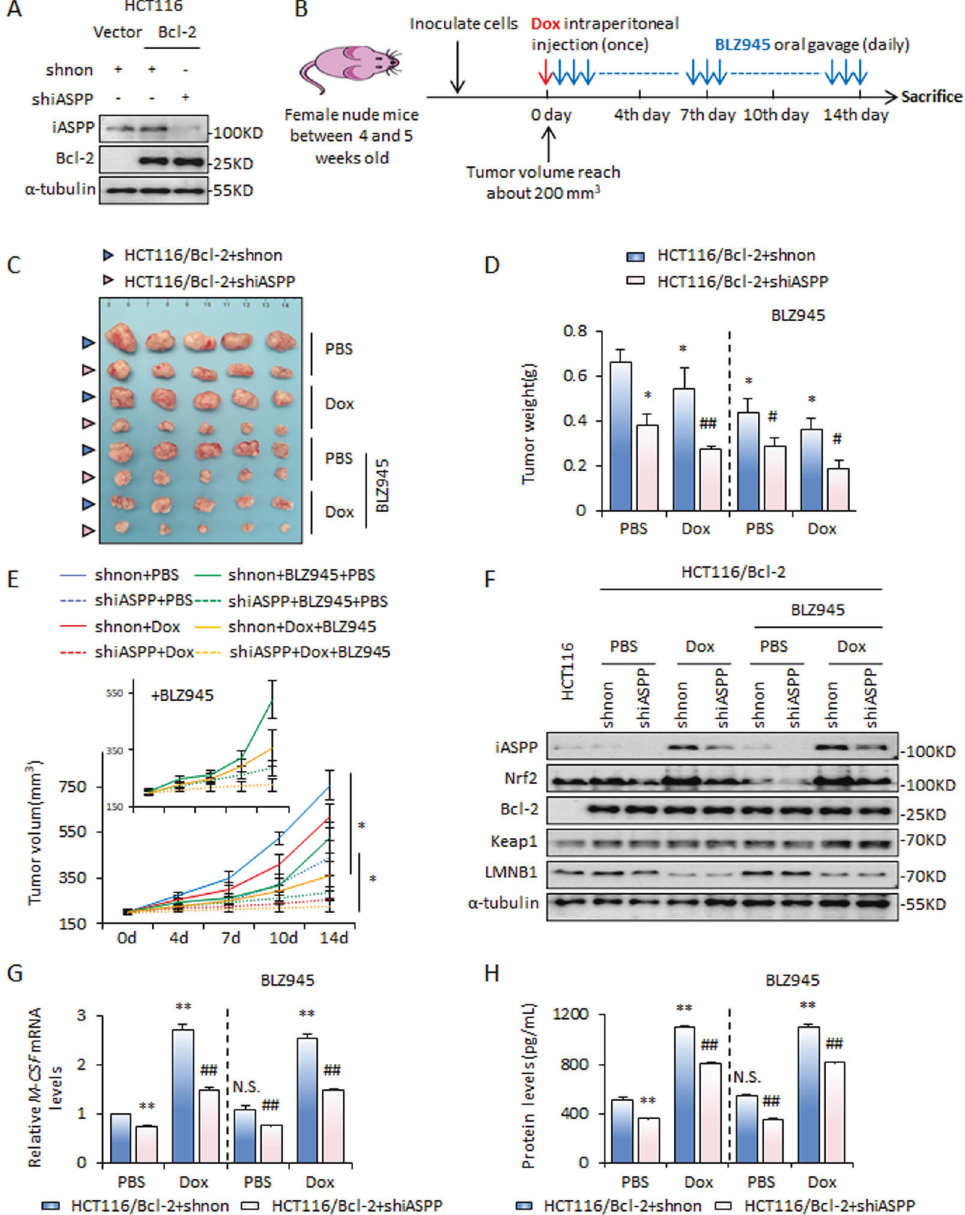
weights ( D ), and tumor volumes ( E ) of HCT116/Bcl-2 xenografts on the indicated time points after treatments. N = 6/group. Values are mean ± SD ( D , E ). F Expression levels of iASPP, Nrf2, Bcl-2, Keap1, and LMNB1 proteins in the indicated xenografts were determined by western blot. α